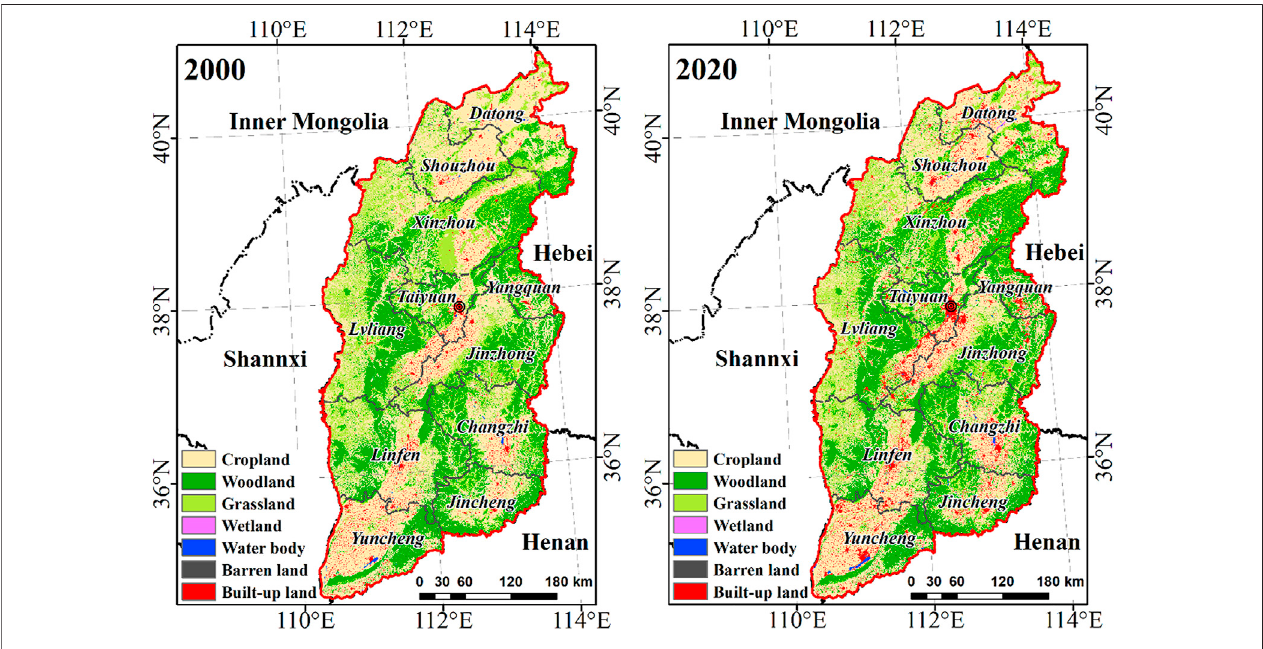
FIGURE 2 | The spatial distribution of land cover types in 2000 and 2020.